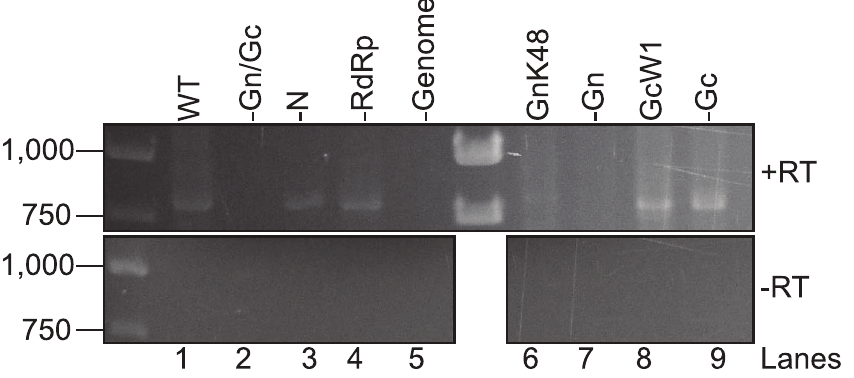
Figure 7. Genomic RNA is packaged into RVF-VLPs that lack RdRp. BSR-T7/5 cells were transfected with genome and all of the structural proteins (WT), or one or more of the components was replaced with an equivalent amount of empty vector (-Gn/Gc, -N, -RdRp, -genome, -Gn and -Gc) or with plasmids expressing mutant alleles of Gn or Gc (GnK48 or GcW1). At 24 h the media was replaced with fresh media containing benzonase nuclease. At 48 h the media was removed, clarified and the RVF-VLPs were harvested by ultracentrifugation. The RNA was isolated from the RVF-VLPs and cDNA was generated with primers that recognize the genomic termini and reverse transcriptase ( + RT). Duplicate samples were also run without reverse transcriptase (-RT). PCR was performed using primers that flank the intergenic region. The numbers on the left of the gel image indicate size standards. doi:10.1371/journal.pone.0018070.g007 PLoS ONE |